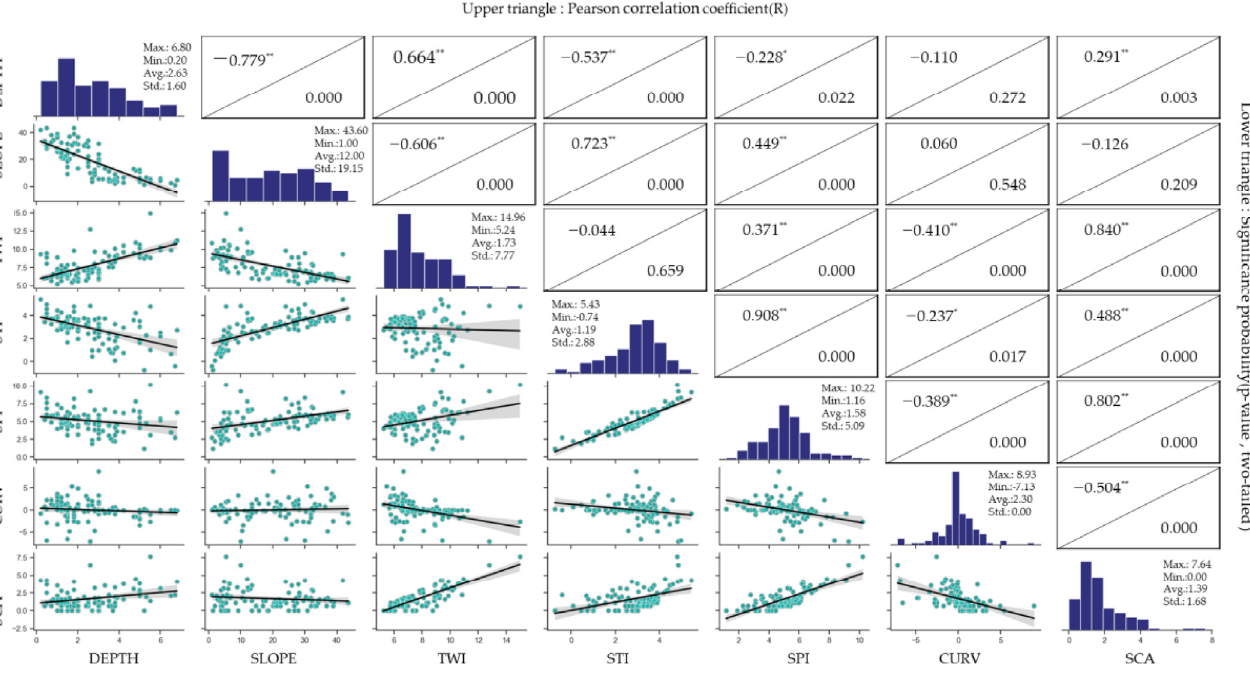
Figure 3. Correlation matrix for igneous rock (* Significant at the 0.05 probability level. ** Significant